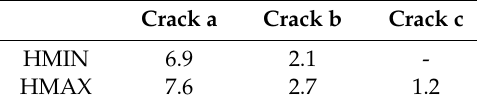
Table 6. The grinding depths of